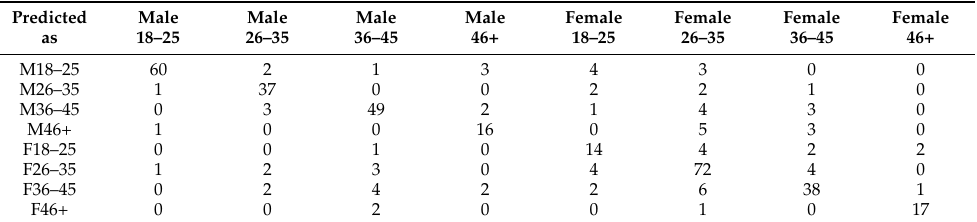
Figure 1. The best performances of the five classifiers. (SVM—support vector machine; SL—simple logistic; NB—Naïve Bayes; BNC—Bayesian Network Classifier; RBFN—Radial Basis Function Network). Table 10. Confusion matrix of the experiment with the highest accuracy.